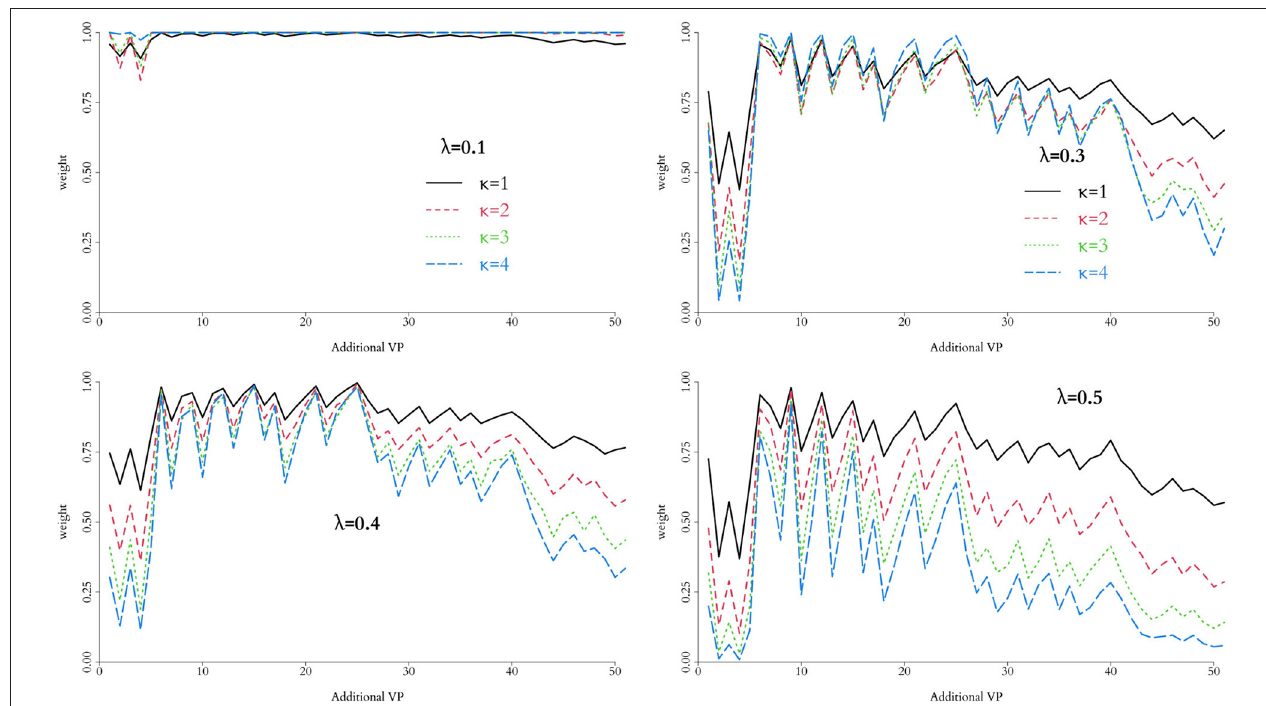
FIGURE 6 | Weight associated with each combination of parameters in the weight function, h ( p ), for the Control group. Relative low values of λ do not provide clear separation, regardless of the potential number of additional virtual patients. For the data observed, λ = 0.4 and κ = 1 provide a reasonable separation and suggest adding 18-25 virtual patients to the combined trial.